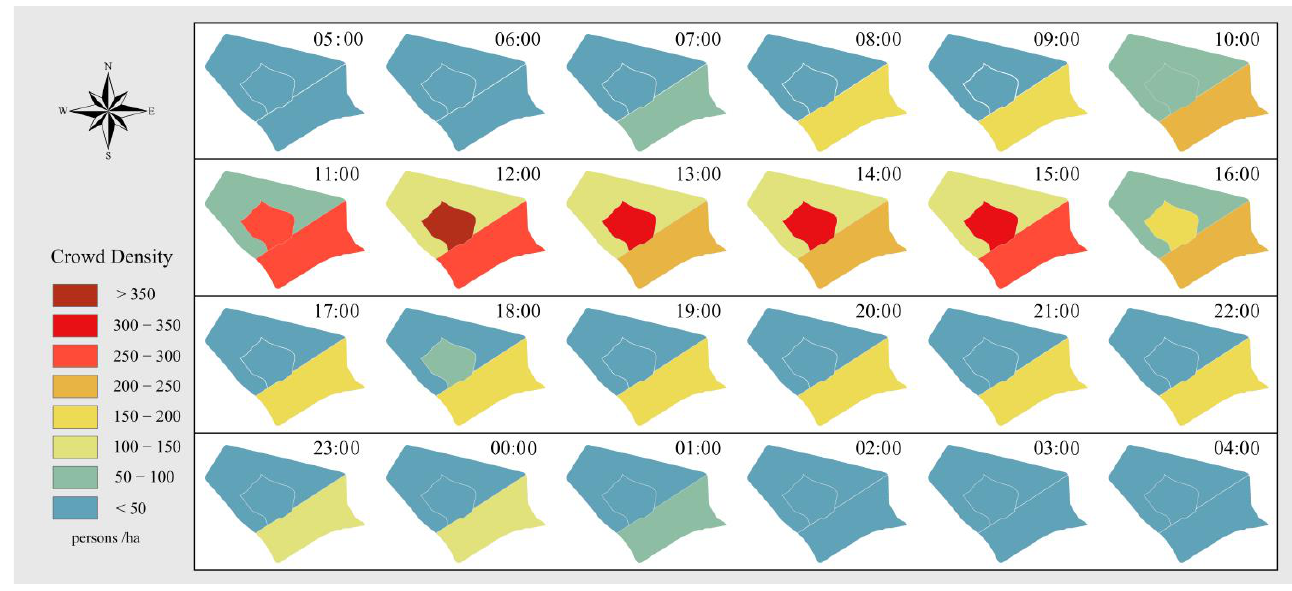
Figure 7. Hourly crowd density of the three areas based on the forecast.